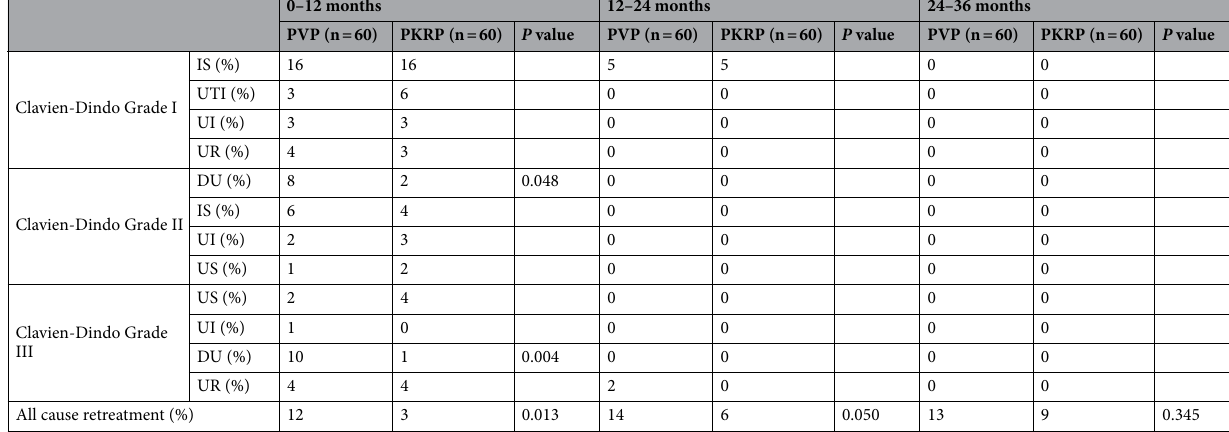
Table 4. Adverse events in each study period. Clavien-Dindo Grade the Clavien-Dindo classification of surgical complications into 5 grades (I, II, III, IV and V), IS irritative symptoms, US Urethral stricture, UI urinary incontinence, UTI urinary tract infection, UR urinary retention, DU